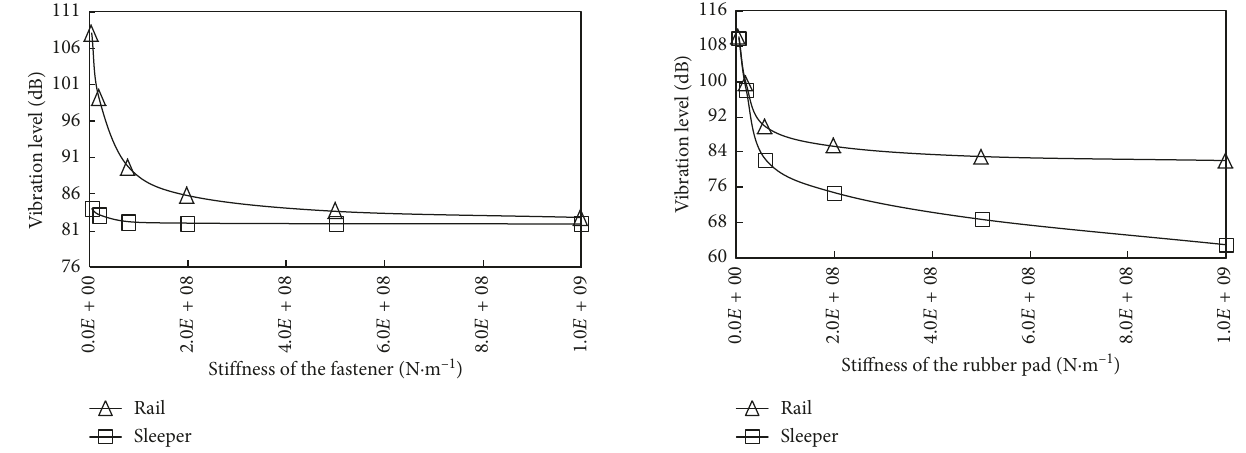
Figure 8: The influence of stiffness of fastener on the vibration power level.